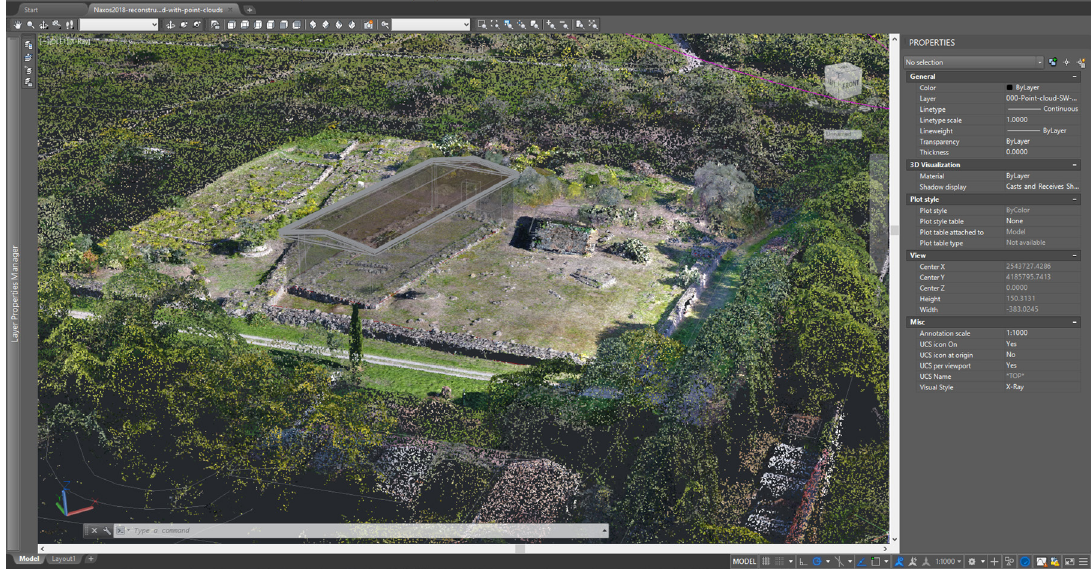
Figure 10. South-West Sanctuary from west. Reconstruction of Temple B superimposed in CAD on the dense point cloud produ- ced in photogrammetry (Jari